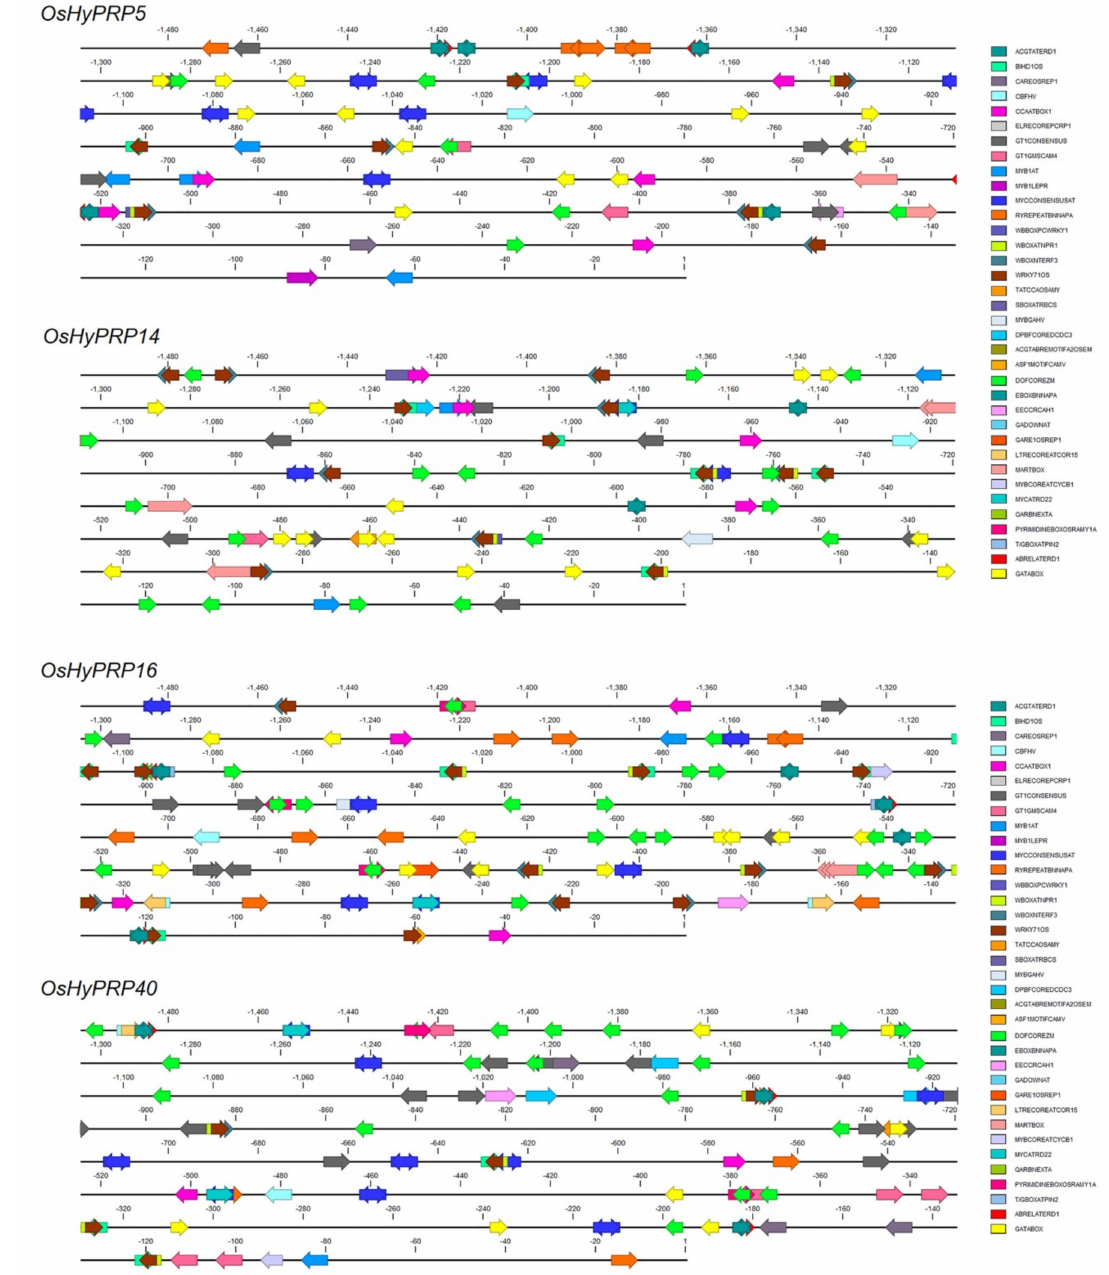
Figure 6. In silico analysis of the promoter region of four OsHyPRPs shows the presence of di ff erent cis -regulatory elements. The 1500 bp region up-stream of ATG start codon was analyzed using the PLACE database webserver. The base immediate upstream of ATG is considered as − 1 and the positions of various cis -regulatory elements are relative to − 1 position. Arrows at the cis -regulatory elements indicate the position of elements on either + strand (forward direction) or − strand (reverse